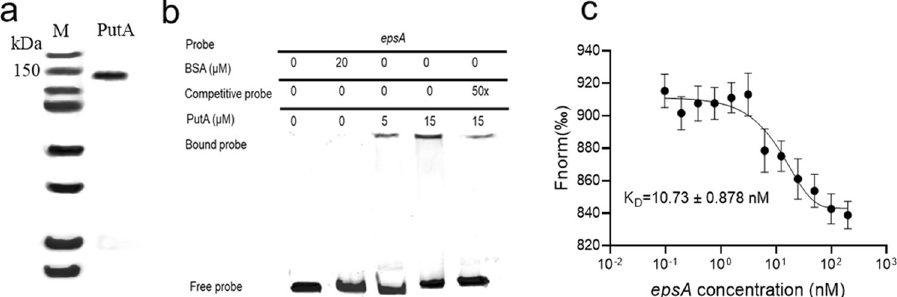
Fig. 2 Analysis of the binding between PutA and the epsA promoter. a SDS-PAGE of the puri fi ed PutA protein. b EMSA analysis of the binding of PutA to the epsA promoter in vitro. A biotin-labelled 336-bp epsA promoter DNA probe was used for the protein binding assay. A protein-DNA complex, represented by a band shift, was formed when different concentrations of PutA protein were incubated with the probe at room temperature for 30 min. Experiment was performed three times and representative images from one experiment are shown. c MST analysis of the PutA binding to epsA promoter DNA probe. “ Fnorm ( ‰ ) ” indicates the fl uorescence time trace changes in MST response. Results in c is mean ± standard deviations of two independent